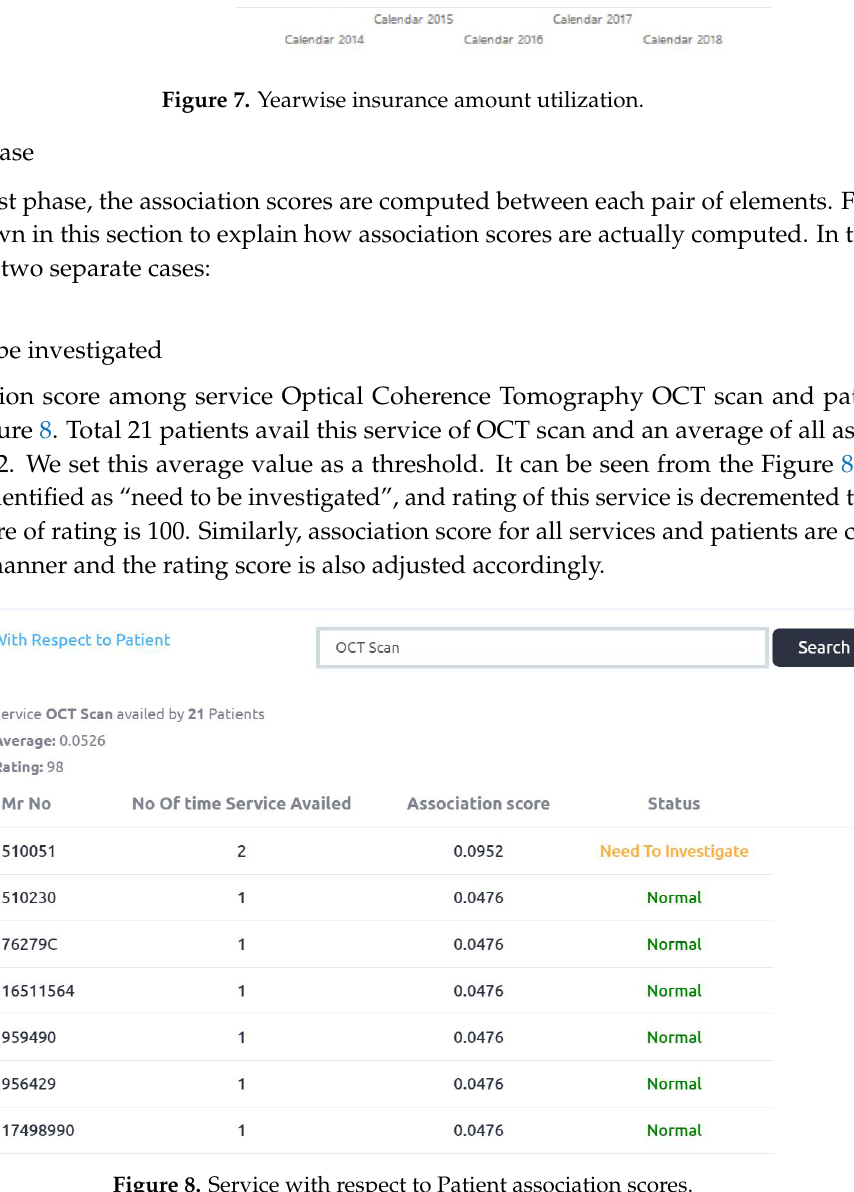
Figure 8. Service with respect to Patient association